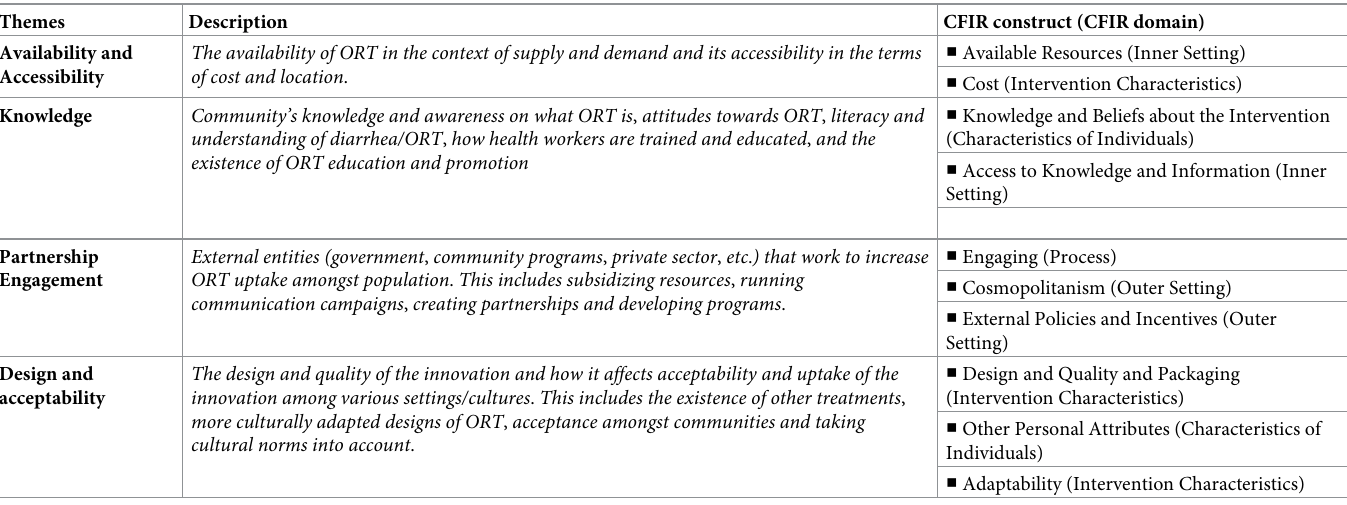
Table 3. Thematic table of cited Consolidated Framework for Implementation Research (CFIR)